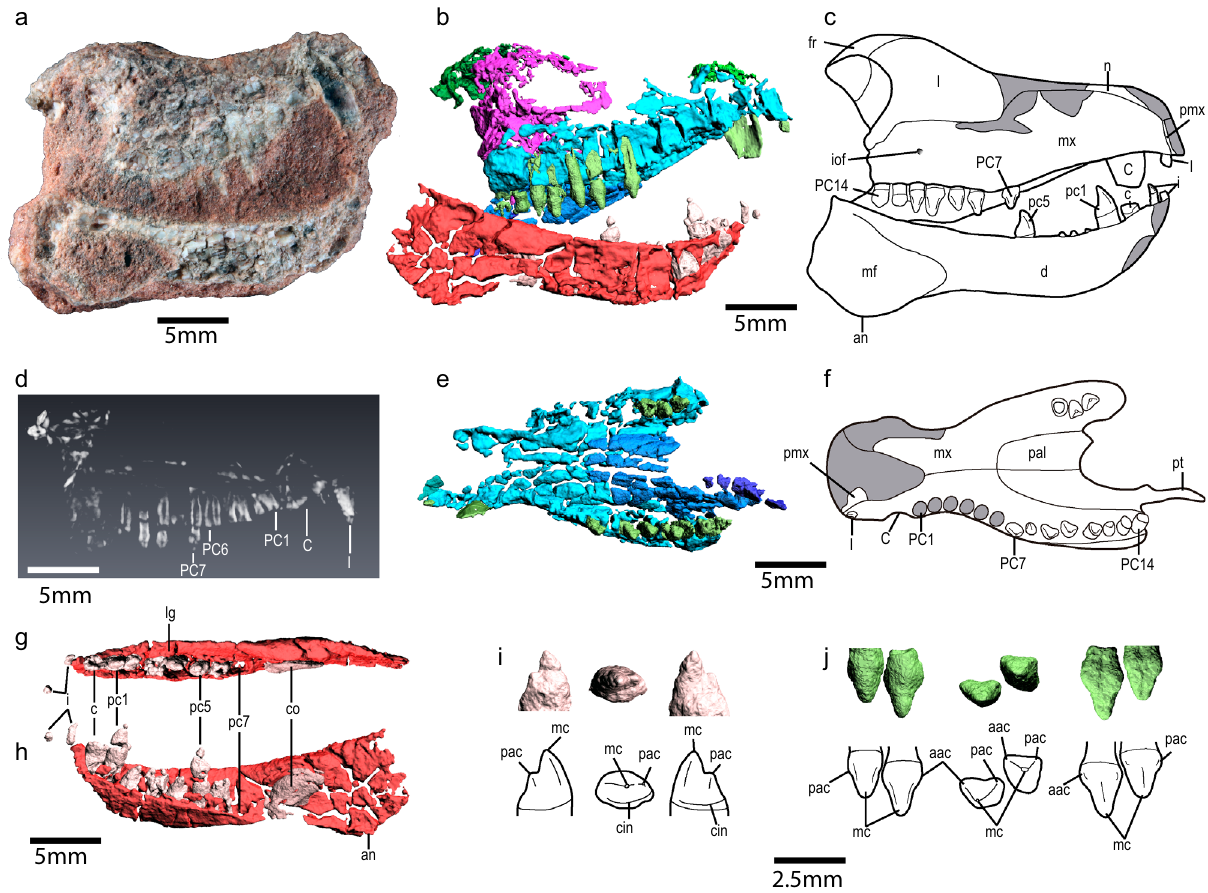
Figure 2. The holotype of Tessellatia bonapartei, gen. et sp. nov. (PULR-V121). ( a ) Cranium as preserved in right lateral view; ( b ) 3D model of the cranium in right lateral view; ( c ) interpretation line drawing of the skull and right lower jaw (restored to its natural position) in right lateral view; ( d ) digital render of the skull showing the roots of the anterior upper postcanines, not visible externally; ( e ) 3D model of the osseous secondary palate and upper teeth in ventral view; ( f ) interpretation line drawing of the osseous secondary palate and upper teeth in ventral view; ( g ) right lower jaw in dorsal view; ( h ) right lower jaw in medial view; ( i ) 3D model of the pc4 in labial, occlusal and lingual views (from left to right); ( j ) 3D model of PC9 and PC10 in labial, occlusal and lingual views (from left to right). aac anterior accessory cusp, an angular process, C / c upper/lower canines, cin cingulum, co coronoid, d dentary, fr frontal, I / i upper/lower incisors, iof infraorbital foramen, l lacrimal, mc main cusp, mf masseteric fossa, mx maxilla, n nasal, pac posterior accessory cusp, pal palatine, PC / pc upper/ lower postcanines, pmx premaxilla, pt pterygoid. Scale bars a-h: 5 mm; i-j: 2.5